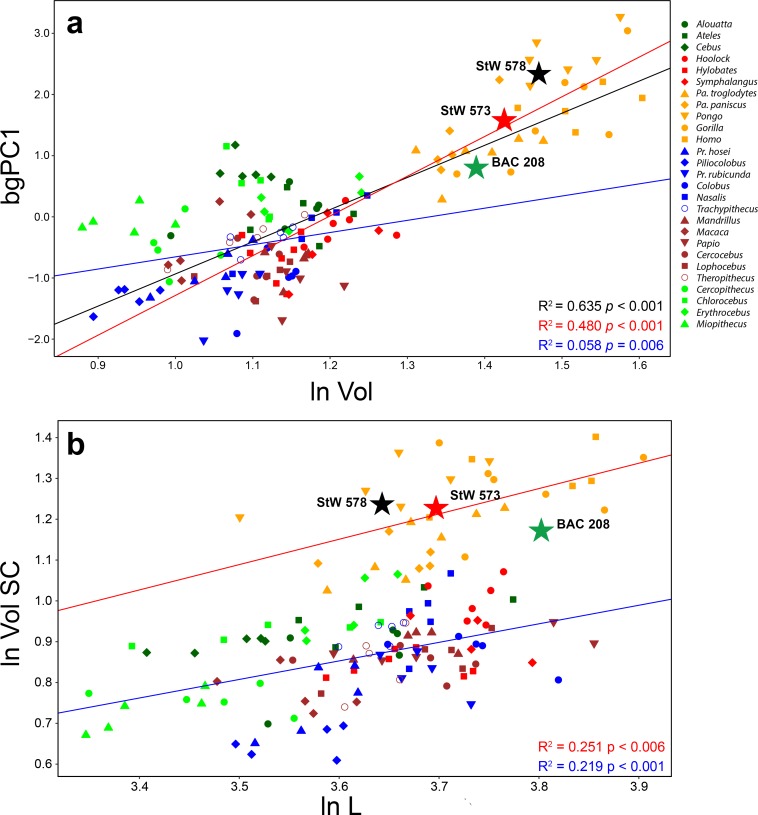
Bivariate regressions between (a) vestibular shape (as represented by bgPC1) and log-transformed cube root of vestibular volume (ln Vol), and (b) semicircular canal log-transformed cube root of volume (ln VolSC) vs.log-transformed length (ln L).Lines represent OLS best-fit lines for the whole anthropoid sample (black), hominids (red), and other anthropoid taxa (blue). Note that there is a significant correlation between bgPC1 (which captures differences in SC thickness and macular organ size) and vestibular volume, more marked in hominids than in the rest of the sample (see Table 3 for further details). Note as well that hominids and other anthropoids show a similar negatively allometric relationship between the cube root of volume and length of the SCs, but with a marked allometric grade shift—such hominids possess stouter canals than other anthropoid taxa at comparable lengths once size-scaling effects have been taken into account (see Table 3 for further details). Both australopiths fall above the regression line for hominids, while Oreopithecus is slightly below, yet well above the regression line for non-hominid taxa. Color code as in Figure 2.Figure 7—source data 1.Linear measurements for the analyzed specimens and used for computing the linear regressions.Table provided as a separate Excel file.